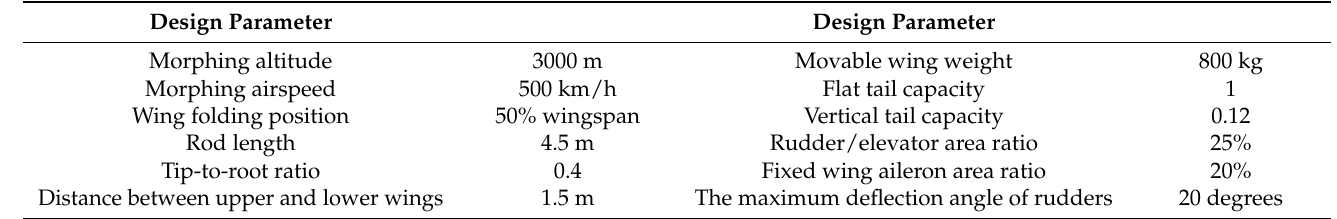
Table 3. Wing and rudder parameters of the mono-biplane aerodynamics-driven morphing